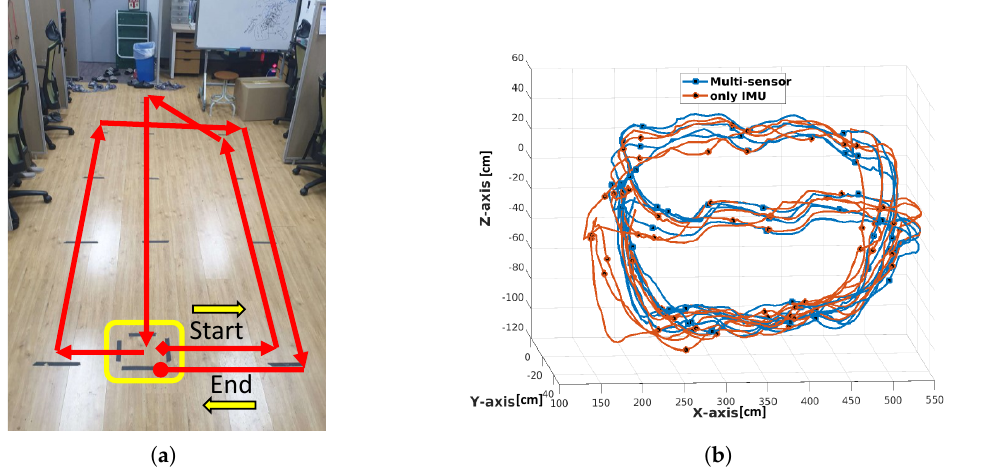
Figure 10. ( a ) Closed loop trajectory path, ( b ) inertial measurement units (IMU) only and multi-sensor system position data trajectory.